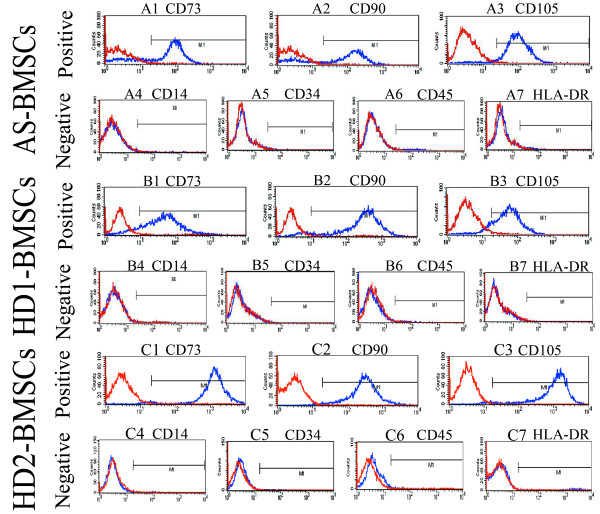
Phenotyping of bone marrow-derived mensenchymal stem cells for typical mensenchymal stromal cell surface markers. Single-parameter histograms for (A1) to (A3), (B1) to (B3), (C1) to (C3) individual mensenchymal stromal cell (MSC) markers and (A4) to (A7), (B4) to (B7), (C4) to (C7) MSC exclusion markers, representative of samples from patients with ankylosing spondylitis (AS) and from healthy donors (blue lines). Red lines indicate background fluorescence obtained with isotype control IgG. x axis, fluorescence intensity; y axis, cell counts. BMSC, bone marrow-derived mensenchymal stem cell; HD1, HLA-B27-negative healthy donors; HD2, HLA-B27-positive healthy donors.